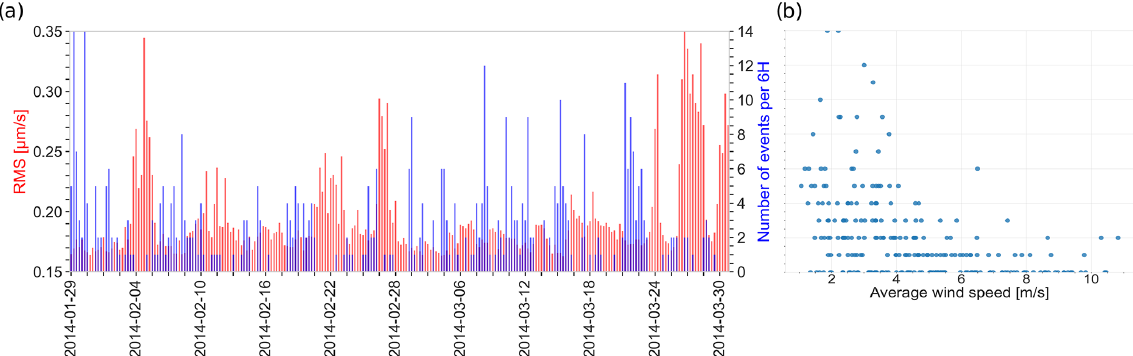
Figure 5. (a) RMS per 6h calculated from the average wind speed and the noise model seen at ELIS vs. the icequake rate per 6h (seismic rate) by Camelbeeck et al. (2019). (b) Icequake rate per 6h vs. average wind speed (ms − 1